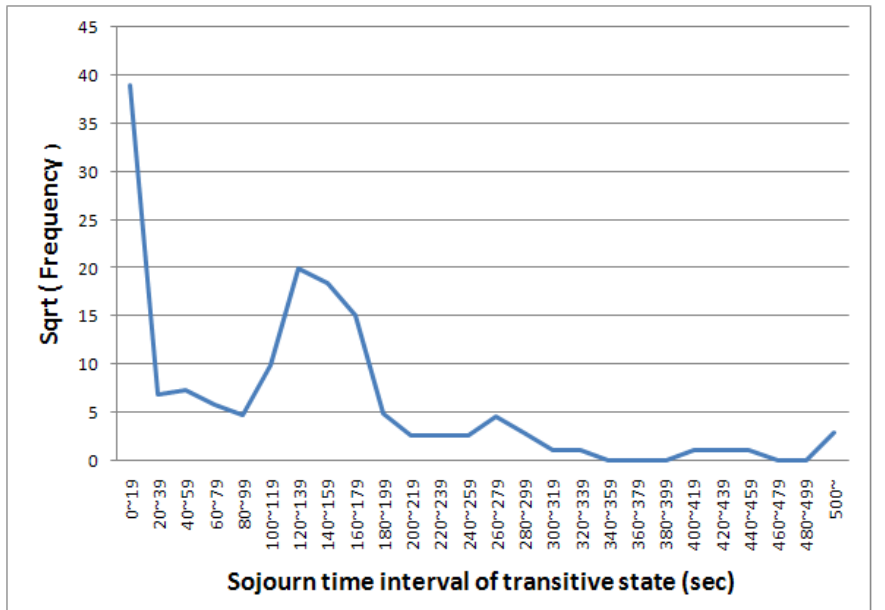
Figure 3. Example of distribution map of sojourn time intervals in the transitive